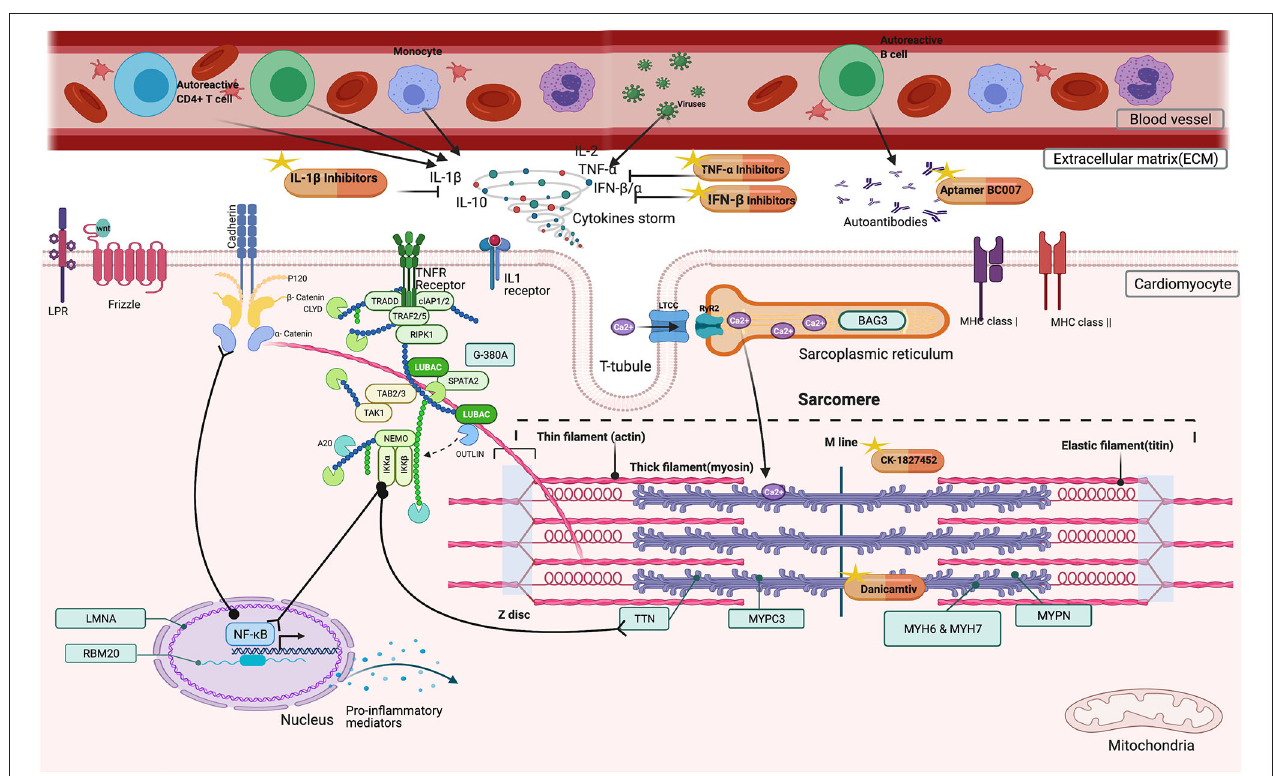
FIGURE 1 | Possible beneficial effects of immunomodulators in DCM patients. Inside the cardiomyocyte, CK-1827452, Danicamtiv accelerates the transition of actin-myosin complex in the sarcomere. In the extracellular matrix (ECM), TNF- α , IL-1 β Inhibitors, and IFN β , Interferon beta downregulates the cytokine storm by inhibiting several factors (TNF- α ,Tumor Necrosis Factor alpha, IL-1 β Inhibitors, Interleukin − 1 beta, IL-2, Interleukin-2, IL-10 Interleukin-10, IFN β , Interferon beta, IFN α , Interferon alpha). Aptamer BC007 acts on AAB